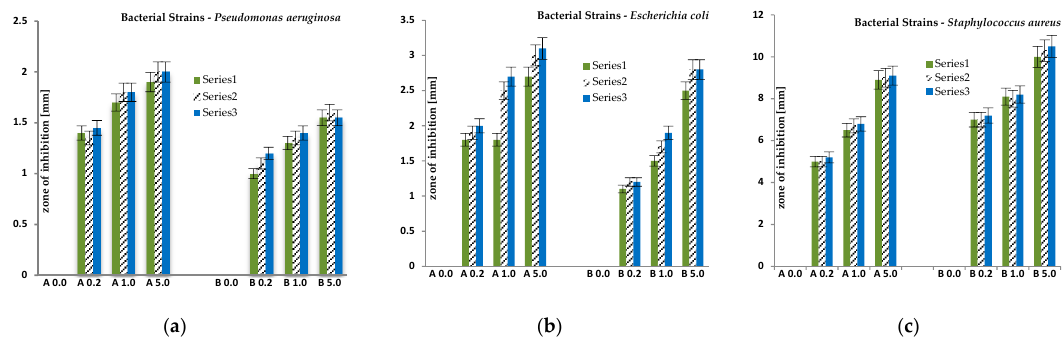
Figure 14. Inhibition zone assay of blends of fibres against P. aeruginosa ( a ), E. coli ( b ) and S. aureus ( c ).